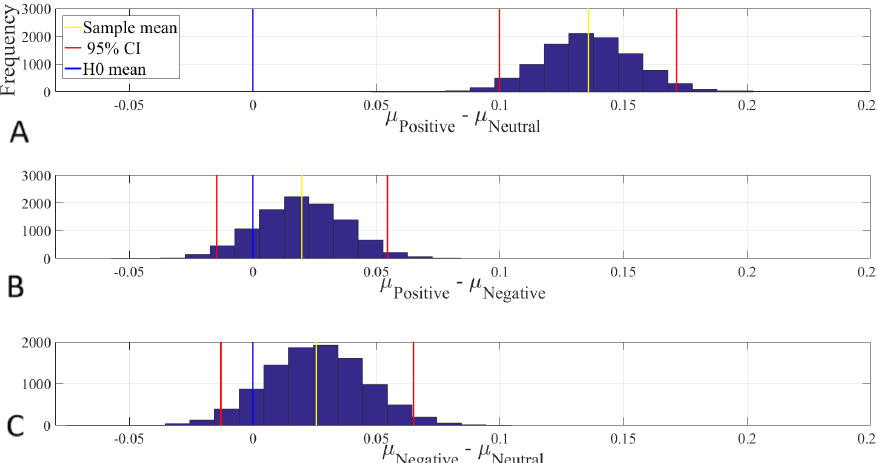
Figure A15. ( A ) Grand averages of the spatial maps of participants’ PE5 values (i.e., 62 PE5s associated with 62 EEG channels of a participant, per affect) in negative, neutral, and positive mental states. Distribution of PE5s in these spatial maps corresponds to the EEG channels’ arrangement in Figure 1B in the main text (i.e., one PE5 value, per EEG channel) ( B ) Descriptive statistics of the posthoc Wilcoxon rank sum tests applied on participants’ whole-brain PE5s (i.e., 62 PE5s associated with 62 EEG channels of a participant, per affect).